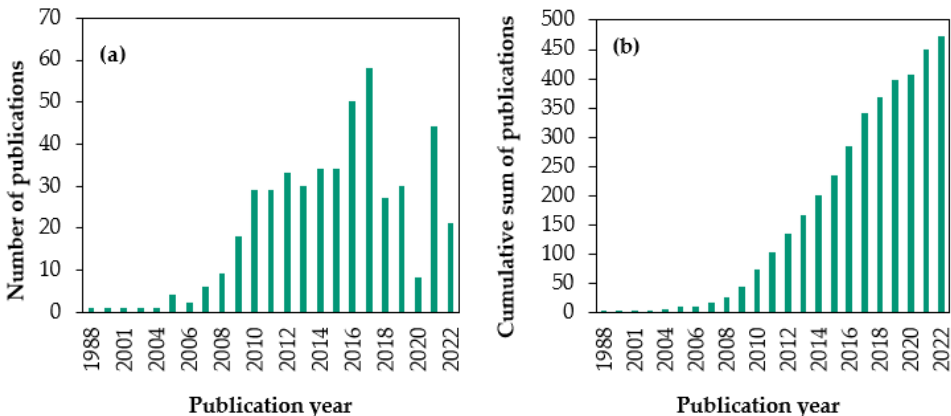
Figure 5. ( a ) The annual number of publications on the hydrogenolysis of glycerol obtained from the Scopus database (“hydrogenolysis of glycerol” as keywords). ( b ) Cumulative sum of publications from 1988 to the present (2022).